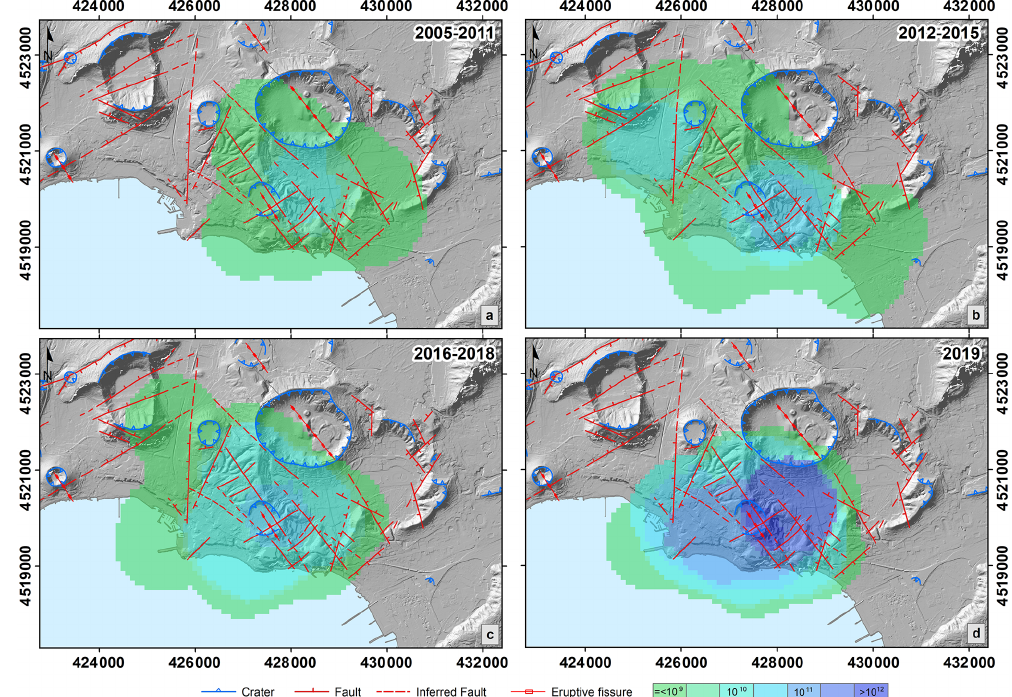
Figure 9. Energy CF-swarms from 2005 to 2019: (a) from 2005 to 2011, (b) 2012–2015, (c) 2016–2018, and (d) 2019. DTM and mor- phostructural map of Campi Flegrei (Vilardo et al., 2013). Reference system UTM WGS84.